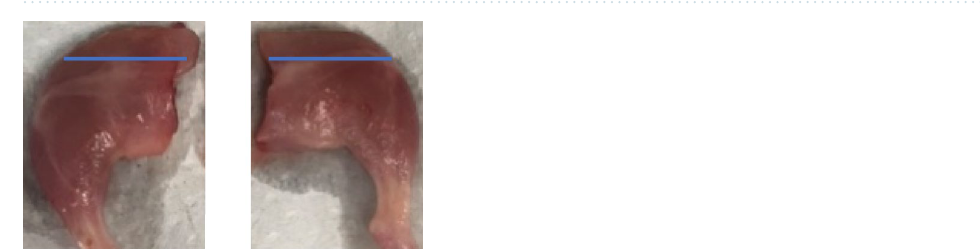
Figure 5. The averaged foot/leg scores (means ± SD; upper panel) and number of mice with scores of > 0 (lower panel) in controls and EU treated mice. D and H: day and hour post-injection. Scoring system: 0 = normal; 1 = closed digits but walked well; 2 = closed digits, no grip; 3 = closed digits, no grip, dragging leg, foot flipped.